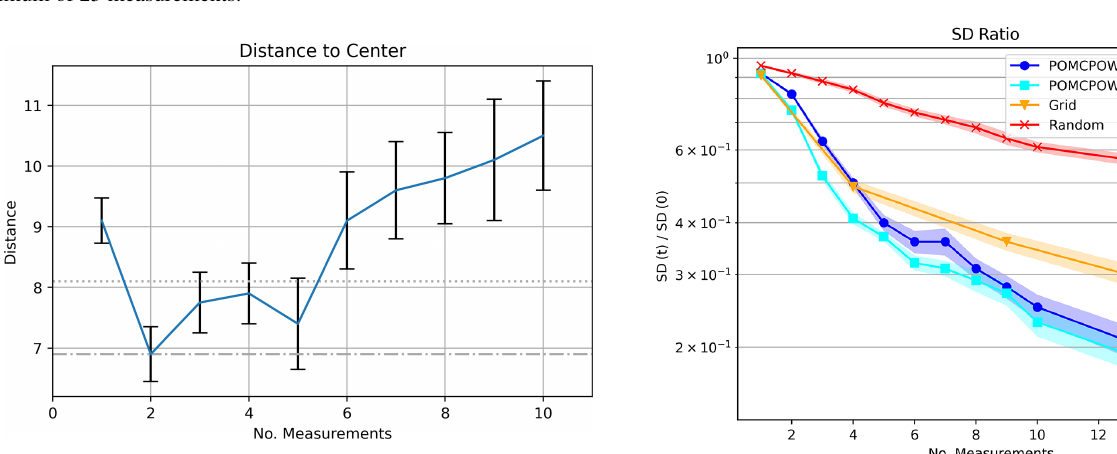
Figure 17. Measurement histogram, POMCPOW without action constraints, single body with fixed location. This figure shows a his- togram of the number of measurements taken by the POMCPOW solver over all Monte Carlo trials. The trials were limited to a max- imum of 25 measurements.